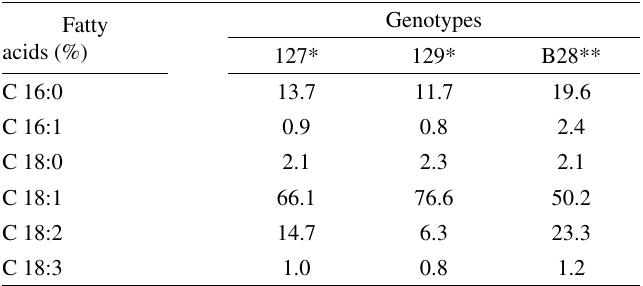
Table 3 - Values for the most important fatty acids in oil from